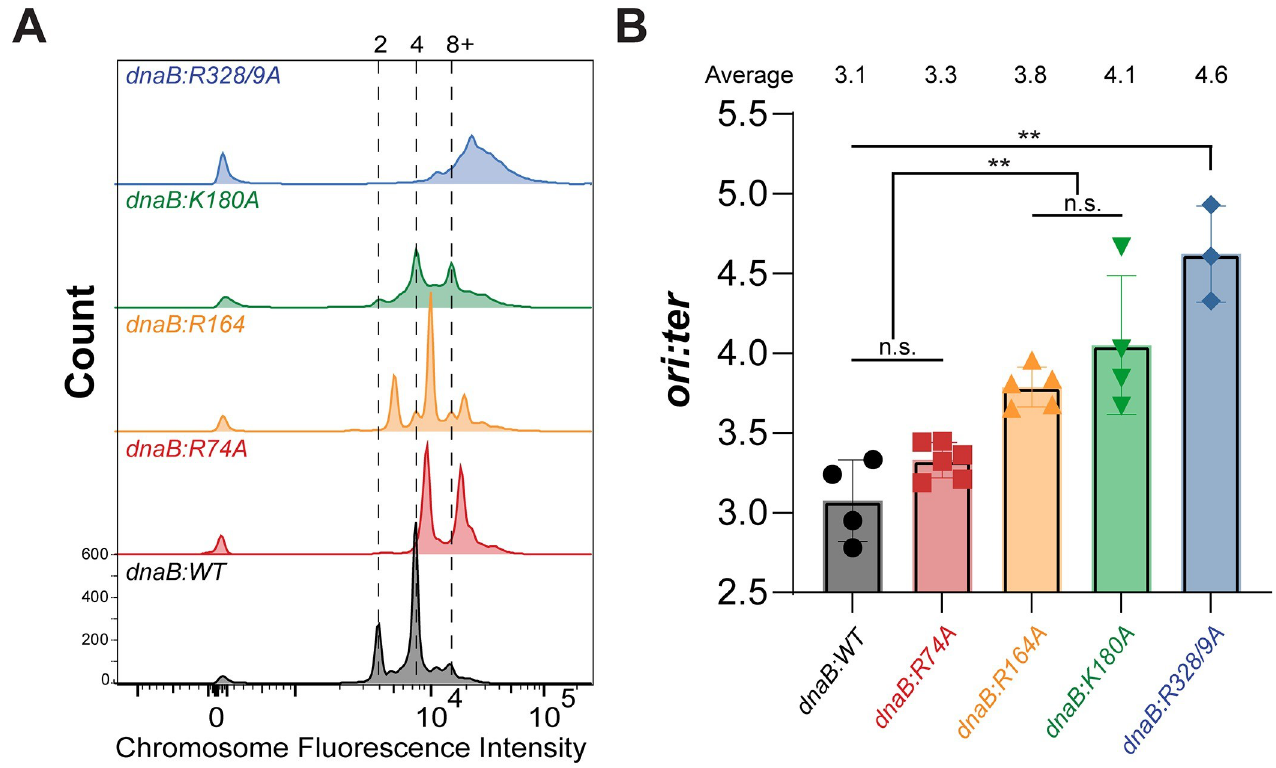
Fig 4. dnaB : muts show changes in chromosome complexity. ( A ) Chromosome density was measured by flow cytometry (FACS) in exponential growth phase rifampicin ‘run-out’ cultures stained with Sytox Green (n = 10,000 events). Chromosome integers are indicated at the top of the graph. ( B ) The ori : ter fold- difference measured by qPCR was calculated using the 2 - ΔΔ Ct method. Individual data is presented with symbols and the average values provided at the top of the plot. Black bars indicate statistically significant differences. Error bars represent ± CV; Black bars indicate statistically significant differences where p-values are �� < 0.01. n.s. is not